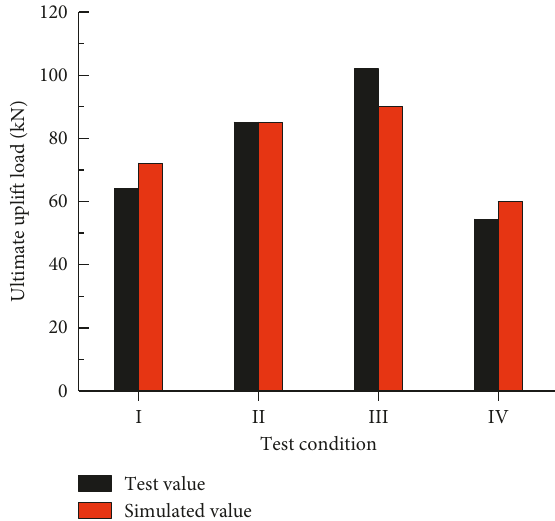
Figure 20: Comparison of measured and simulated uplift bearing capacity.